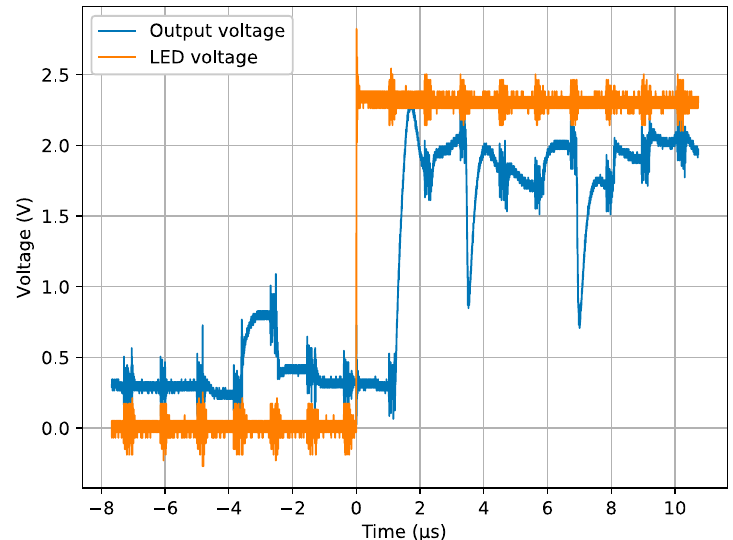
Figure 11. Output and LED voltages measured with a digital 1 GHz oscilloscope. Pixel-reading period is 1.12 µs.